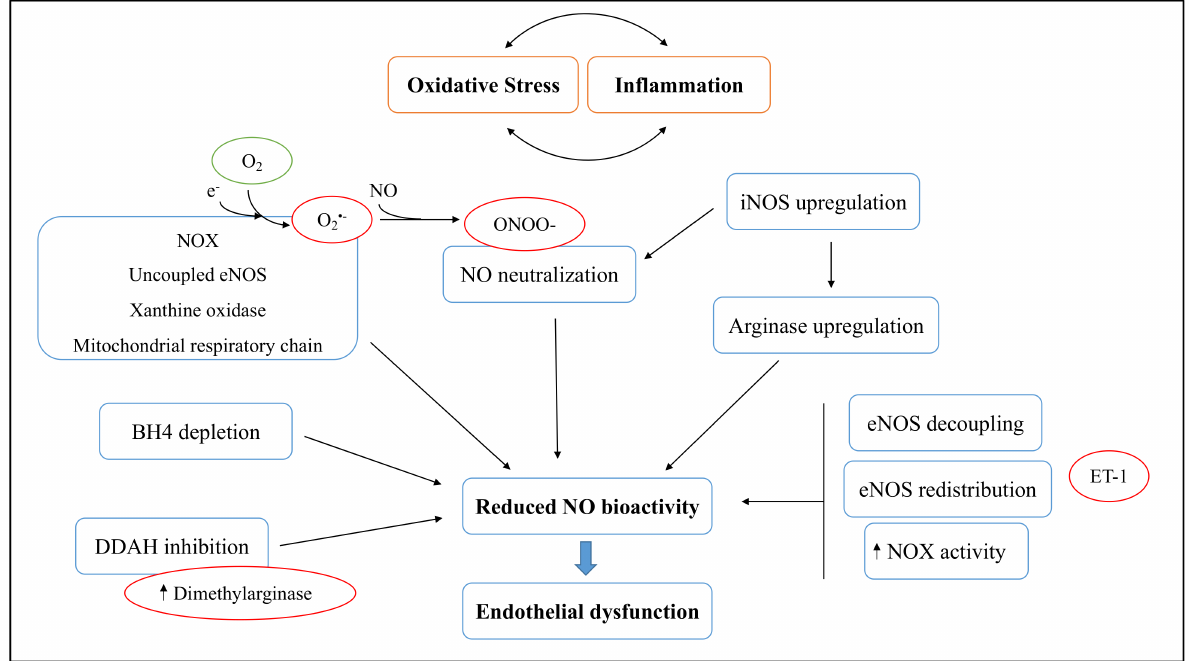
Figure 4. Mechanisms inducing endothelial dysfunction through reduced NO